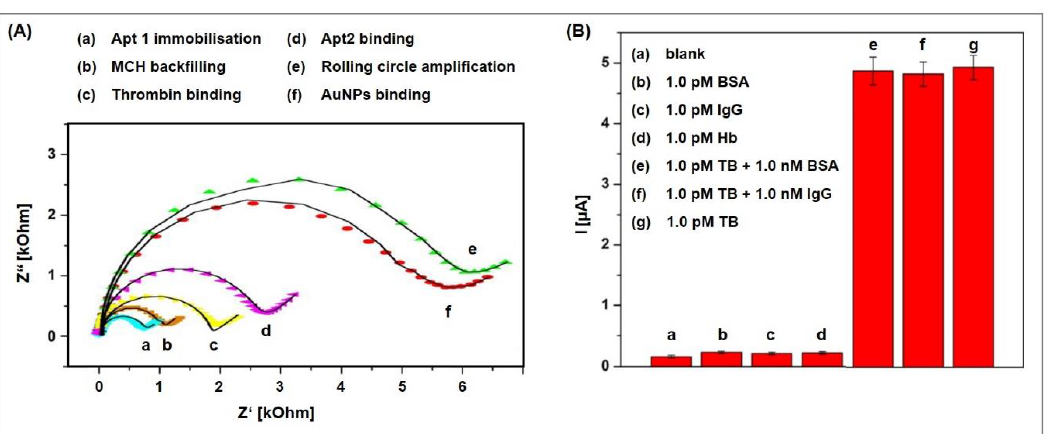
Figure 15. Rolling circle amplification integrated in thrombin aptasensor. ( A ) Nyquist plots of the